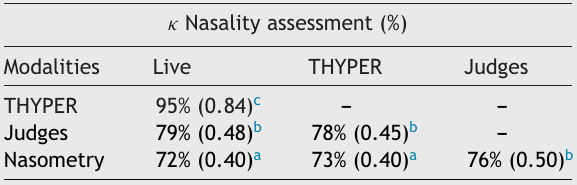
Percentages of agreement (%) and (cid:2) value among the four types of assessment.